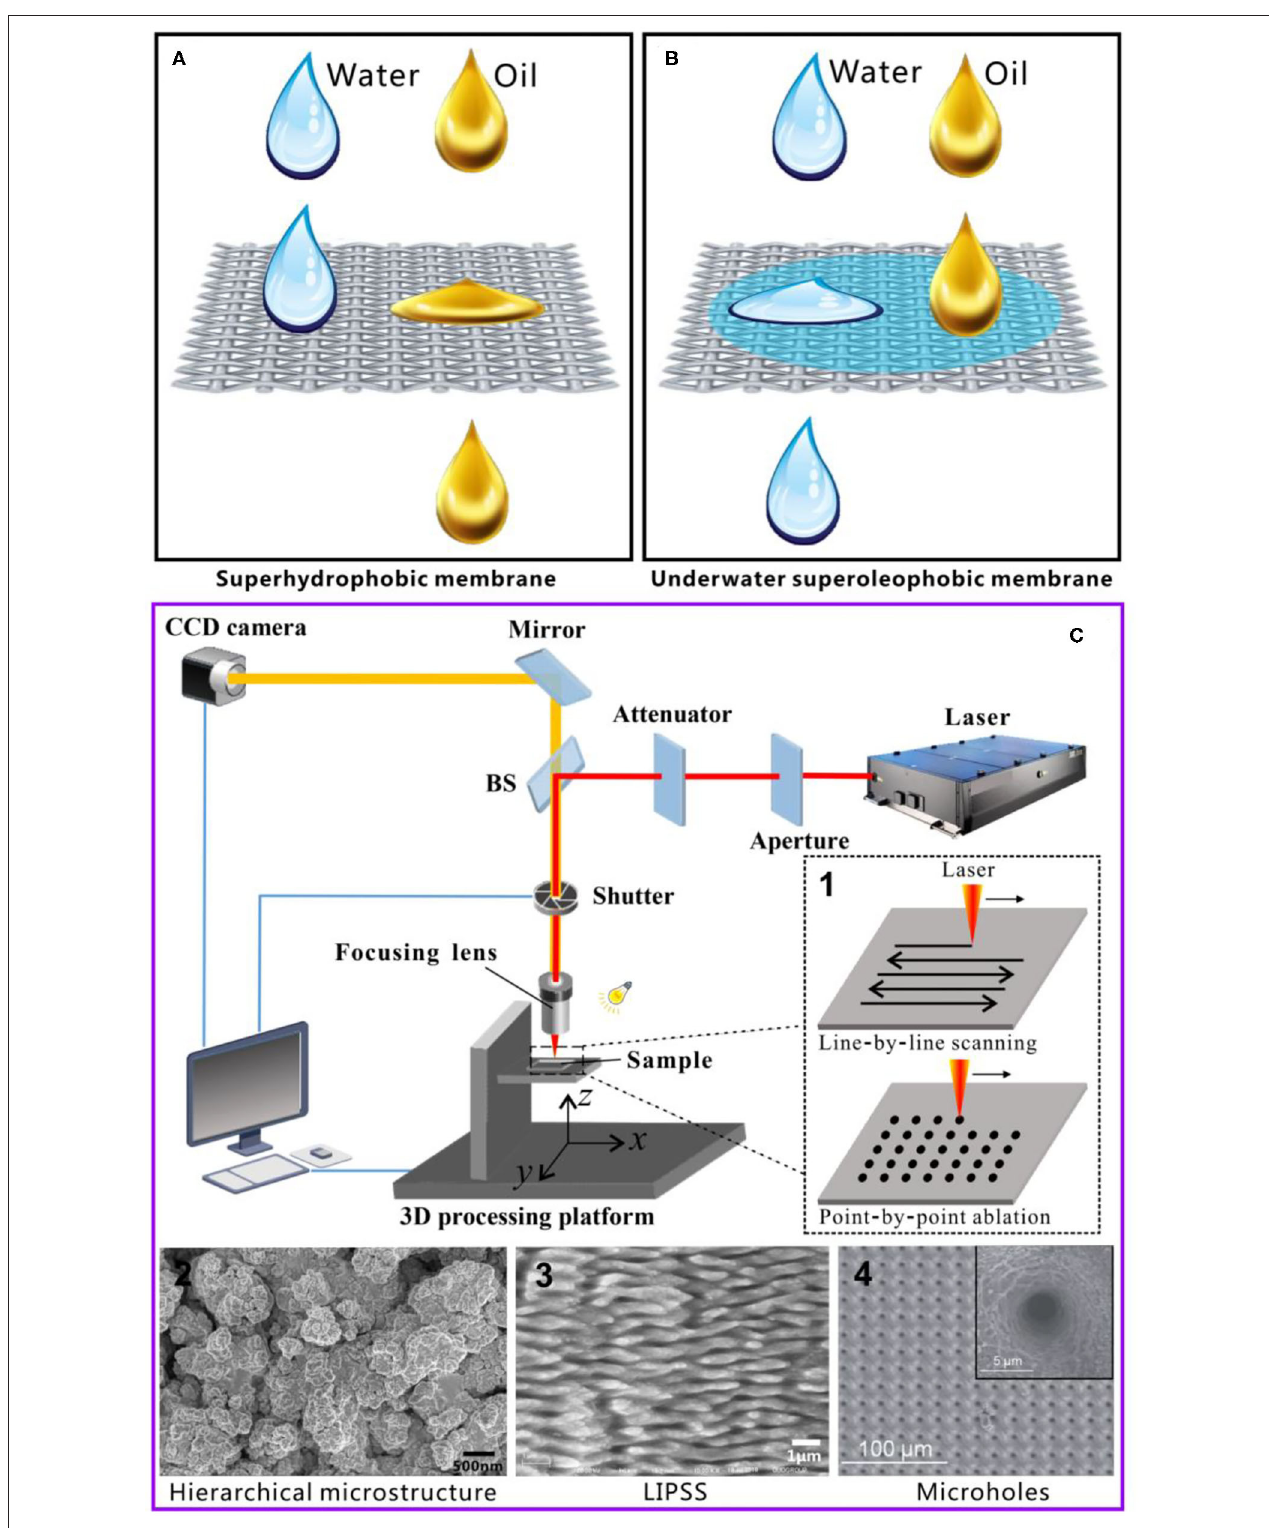
FIGURE 1 | (A) Schematic of OWS by the superhydrophobic porous materials through an “oil-removing” manner. (B) Schematic of OWS by the underwater superoleophobic porous materials through a “water-removing” manner. (C) Schematic of a laser processing system. First inset in (C) : two typical manners (line-by-line scanning and point-by-point drilling) in laser processing. Second to fourth insets in (C) : examples of the typical microstructures induced by femtosecond laser. Reproduced from Yong et al. (2017b, 2019a,b) with the permission of Yong et al. Reproduced from Li G. et al. (2016) with permission of the Royal Society of Chemistry.